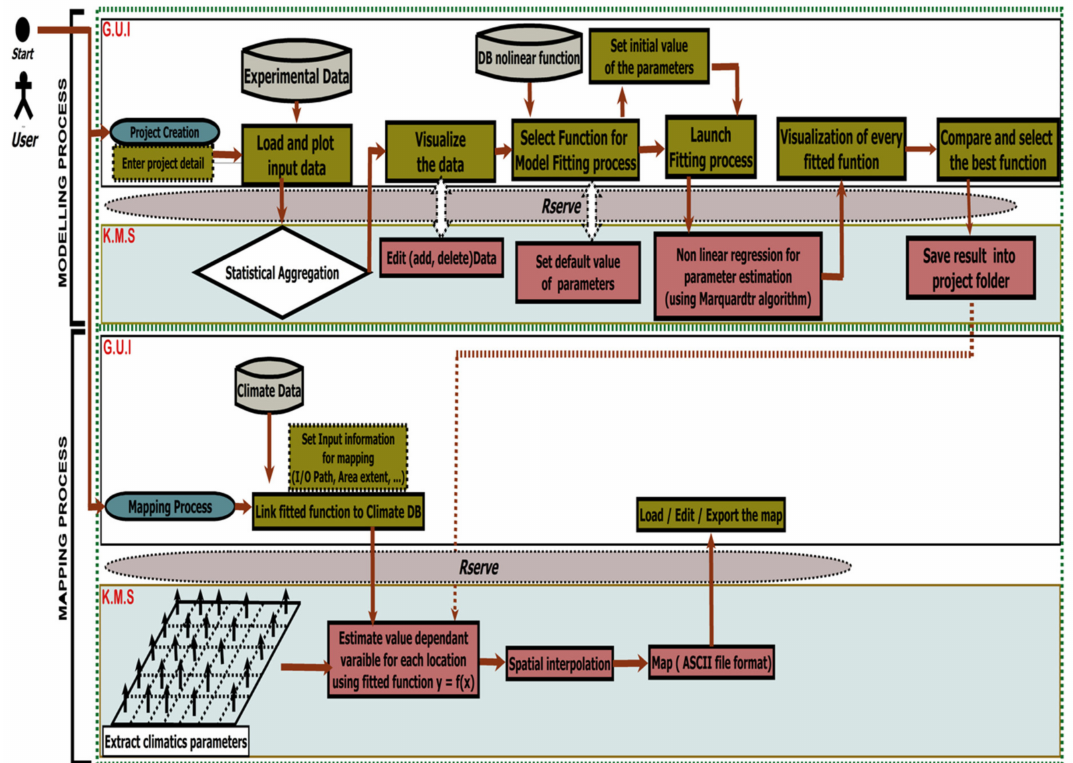
Figure 2. Detailed flowchart diagram of the platform; the figure displays two processes: the fitting process in which experimental data are fitted to nonlinear mathematical expressions using the Marquardt optimization algorithm and the mapping process that begins by linking the obtained best-fitted model to the climate database for map creation. The GUI represents the graphical user interface, and the KMS is the knowledge management system that processes all the